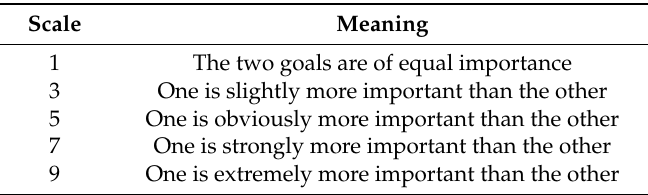
Table 2. The rule of constructing the judgment matrix. Scale Meaning 1 The two goals are of equal importance 3 One is slightly more important than the other 5 One is obviously more important than the other 7 One is strongly more important than the other 9 One is extremely more important than the